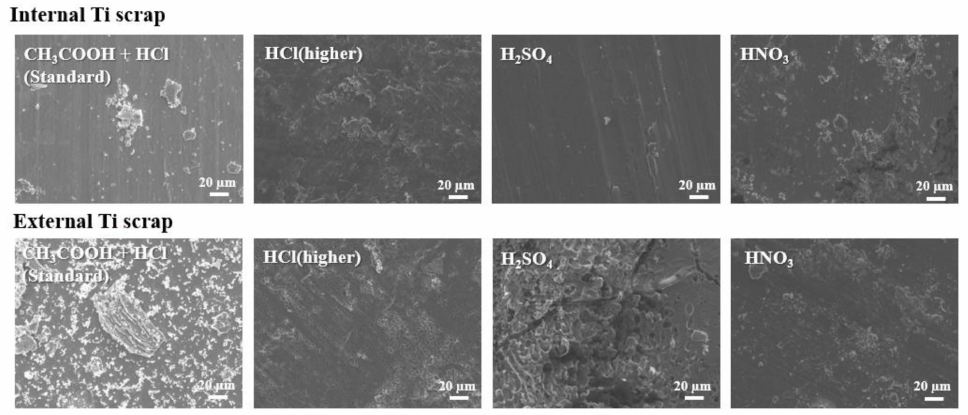
Figure 8. Subsequent treatment results from various solutions to remove impurities remaining on the Ti surface.